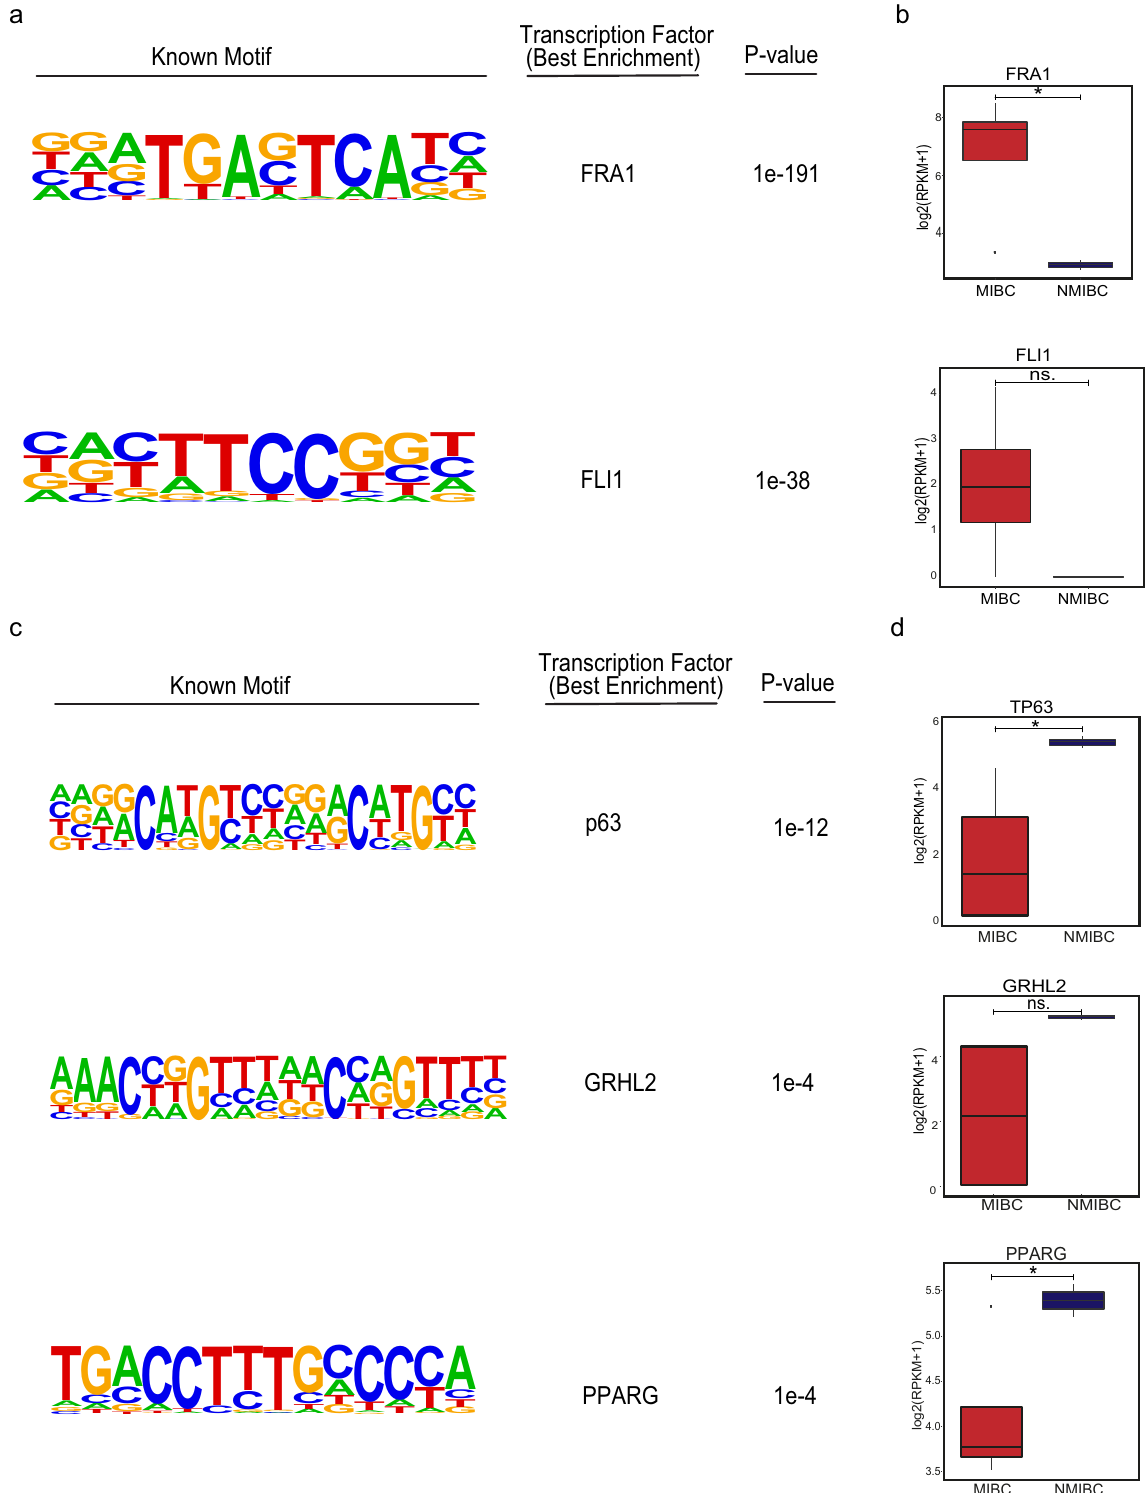
Fig. 3 Transcription factors enriched at MIBC and NMIBC enhancers. a , c Top transcription factor motifs enriched at MIBC ( a ) and NMIBC ( c ) enhancers. b , d Boxplots showing the expression of FRA1 and FLI1 across the NMIBC ( n = 2) and MIBC cell lines ( n = 4) ( b ) and the expression of TP63 , GRHL2 , and PPARG (d). * p -value <